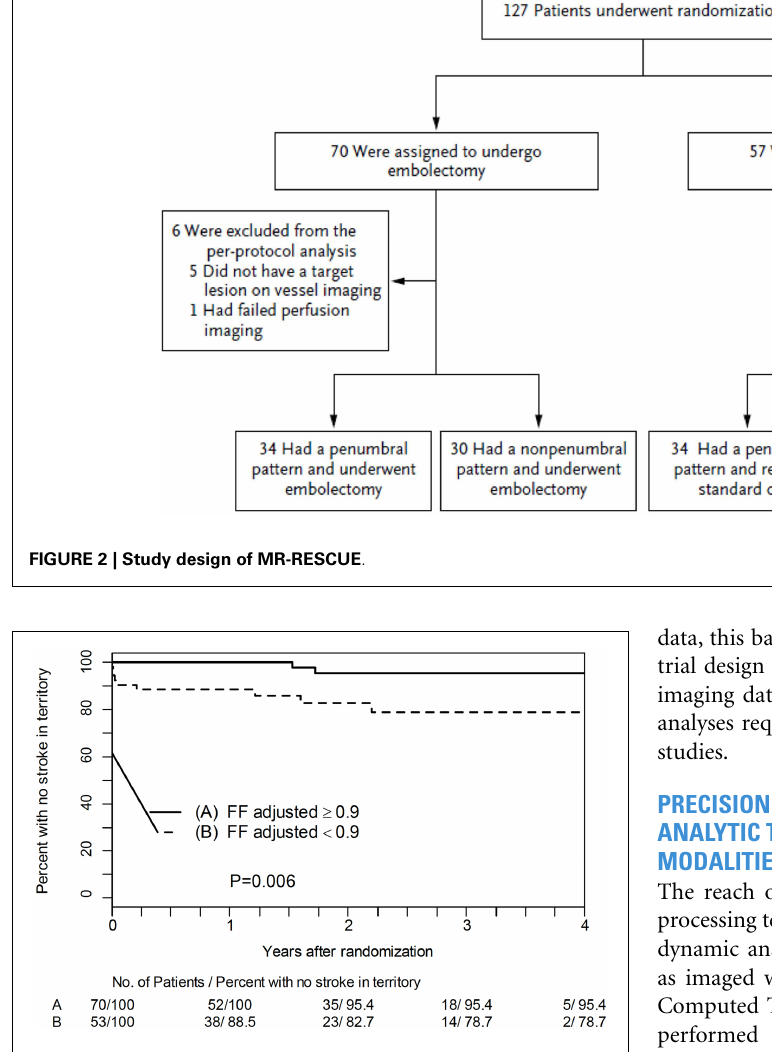
FIGURE 3 | Kaplan–Meier plot for patients with < 70% stenosis surviving without recurrent stroke in the territory as a function of fractional flow assessed non-invasively withTOF-MRA